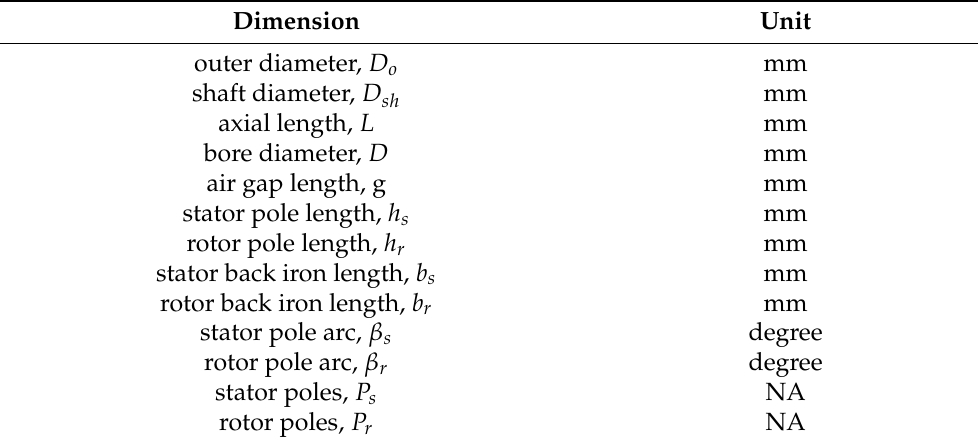
Table 1. SRM dimensions.